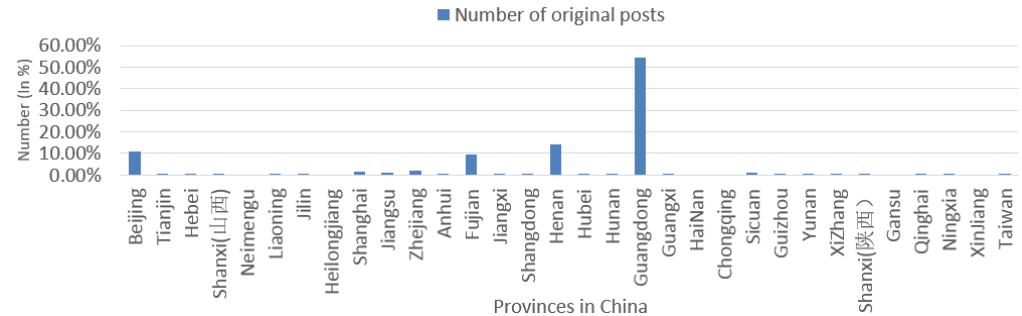
Figure 5. The number of original posts about dengue fever in China on 22 September 2014.